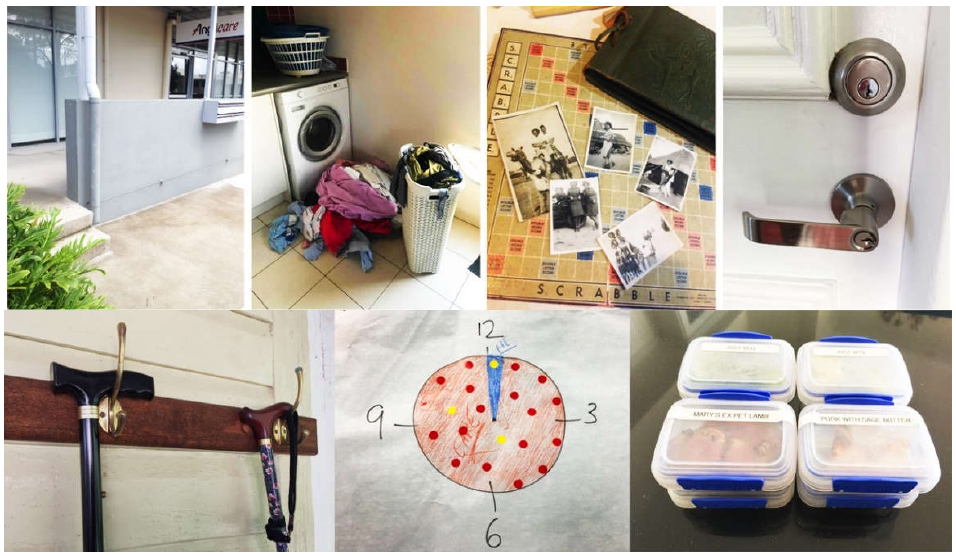
Figure 4. Participants’ photographs of caregiving, and a self-drawing showing little time for them.